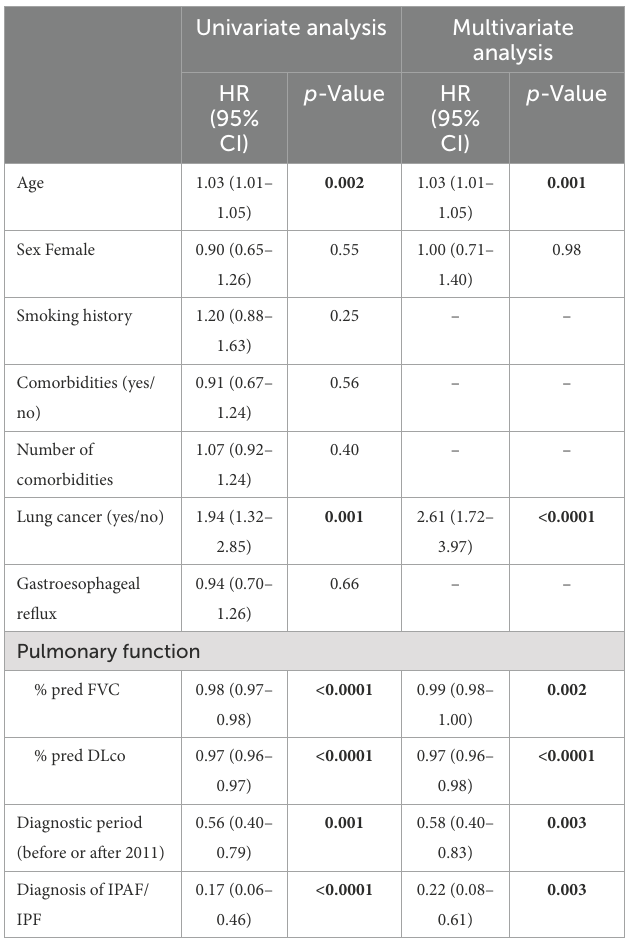
TABLE 3 Univariate and multivariate transplant-free survival analysis comparing IPAF/IPF to non-IPAF/IPF total number of cases IPAF/IPF n = 22, non-IPAF/IPF N = 338.